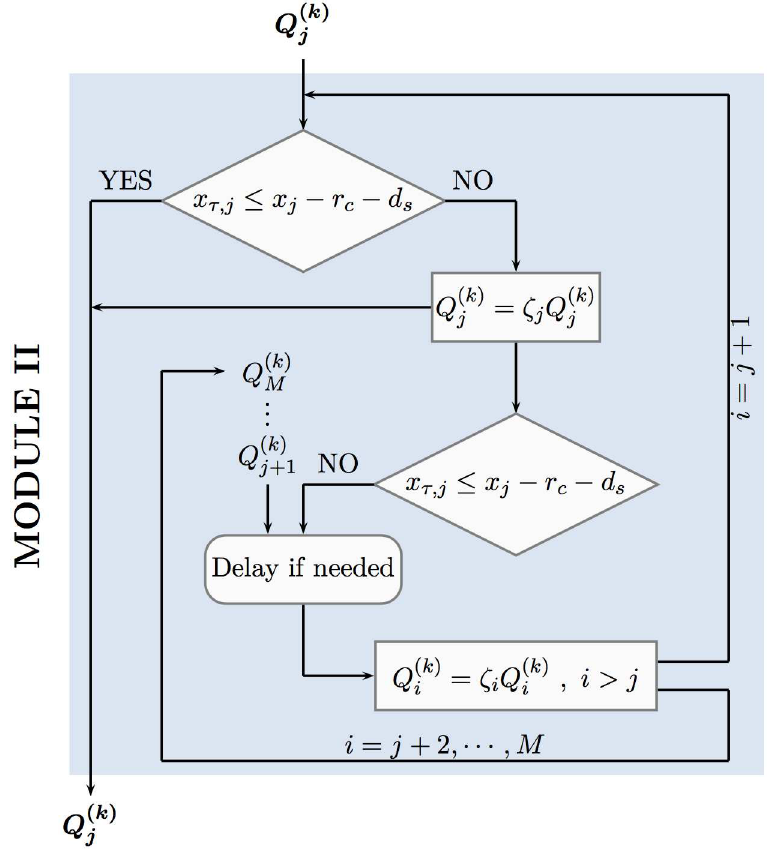
Fig 7. Chart and Data Flow through MODULE